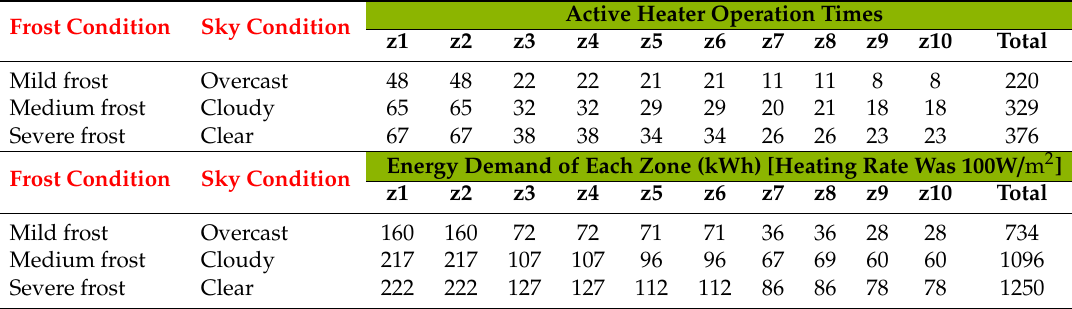
Figure 8. Severe frost canopy temperature simulation results for selected zones z 1 , z 5 , and z 10 . Here, “uc” and “c” denote uncontrolled and controlled cases, respectively. Table 3. Active heater operation times and required minimum energy to prevent frost under three frost